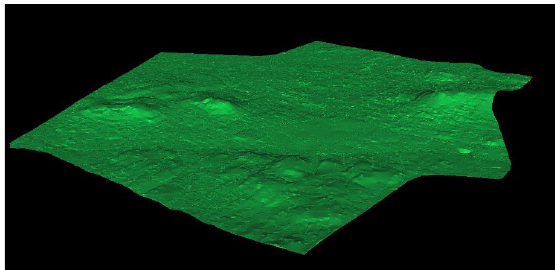
Figure 3: DTM after triangulation and smoothing Objects with low elevation from the DTM are removed from the cloud. In urban areas several constructions may have been recorded in the images and the cloud, such as street lamps, kiosks, signs etc. The more detailed the image, the more